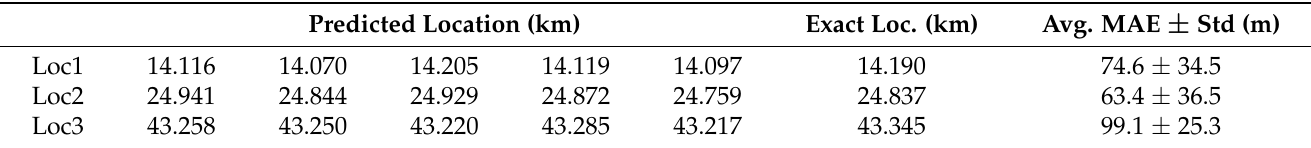
Table 2. Experimental prediction